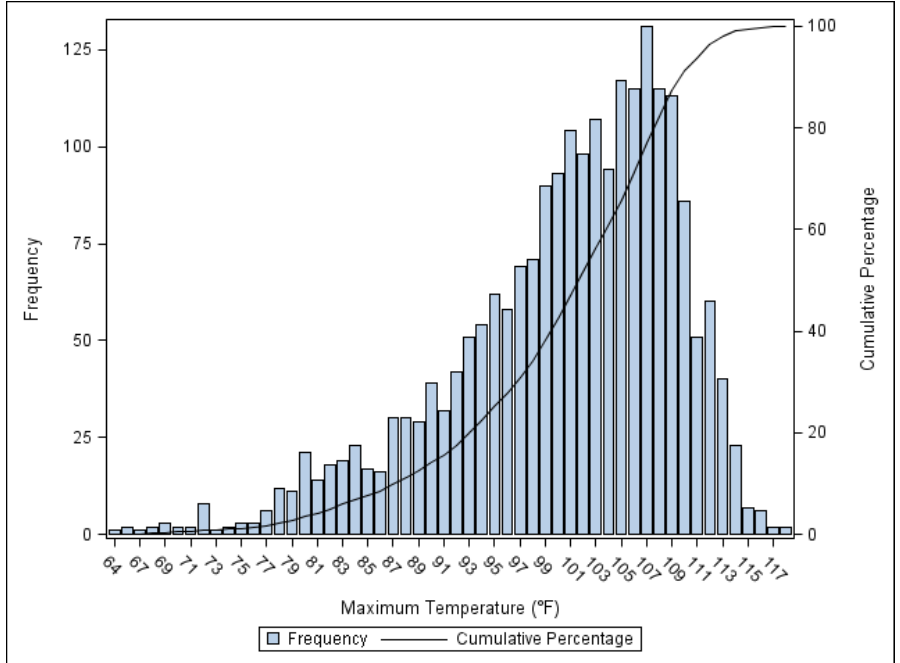
Figure 1. Frequency and cumulative percentage of days by maximum temperature (°F) at the Sky Harbor International Airport Weather Station during the months May–October for years